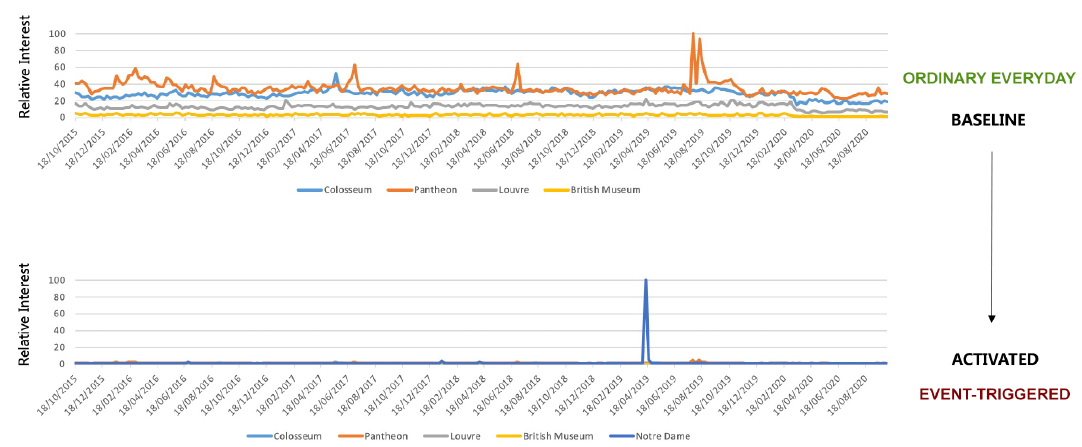
Figure 1. The relative search interest of five heritage properties between 2015 to 2020 on Google Trend search engine. Adding Notre-Dame diminishes the evenly distributed relative search interests. These graphs illustrate both the everyday baseline scenarios (evenly-distributed dates along the two graphs) and activated event-triggered scenarios (the occasional peaks in both graphs).